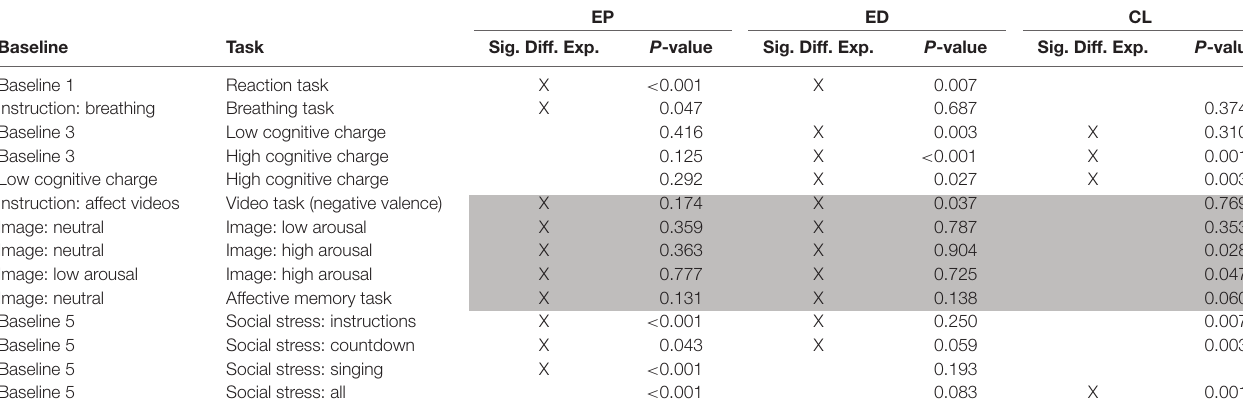
TABLE 4 | Comparisons by task: the phases used as the baseline are listed in the first column and the tasks are listed in the second column. EP ED CL Baseline Task Sig. Diff. Exp. P -value Baseline 1 Reaction task